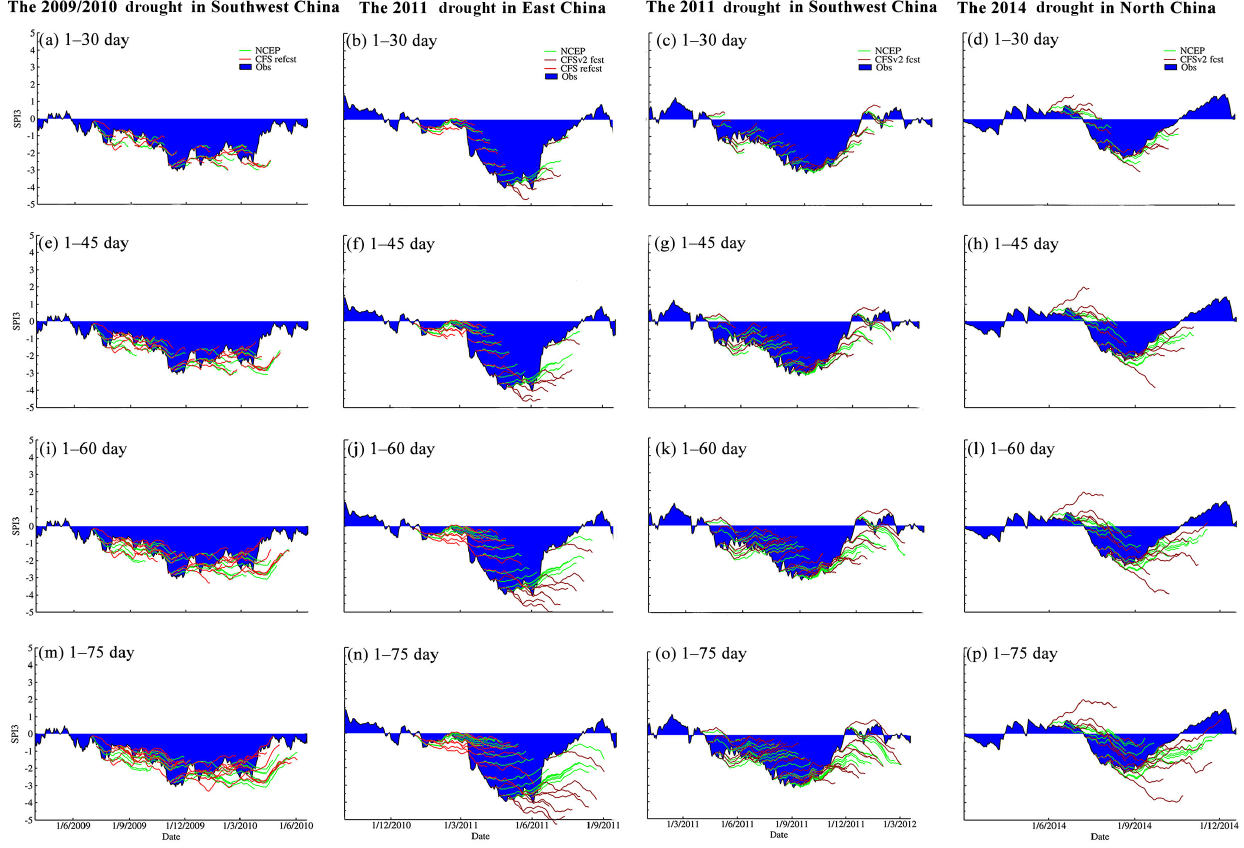
Figure 14. Same as Fig. 12 but for different predicted periods, which are namely the prospective (a) – (d) 1–30-day, (e) – (h) 1–45-day, (i) – (l) 1–60-day, and (m) – (p) 1–75-day periods. “Reforecast” is denoted by “refcst” and “forecast” by